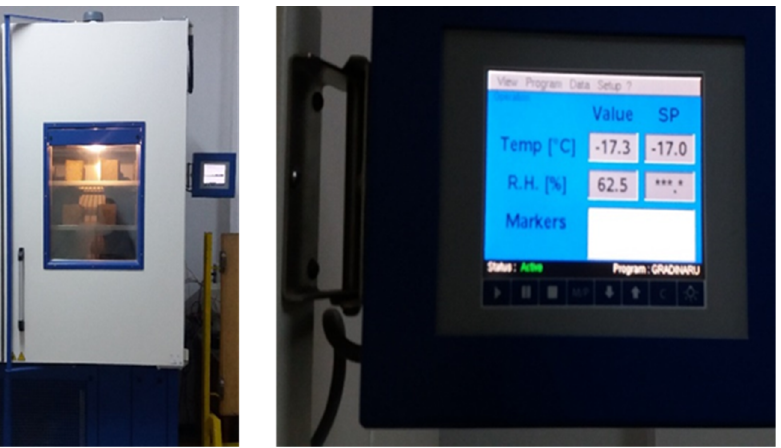
Figure 5. Refrigerated chamber used for freezing the concrete specimens.